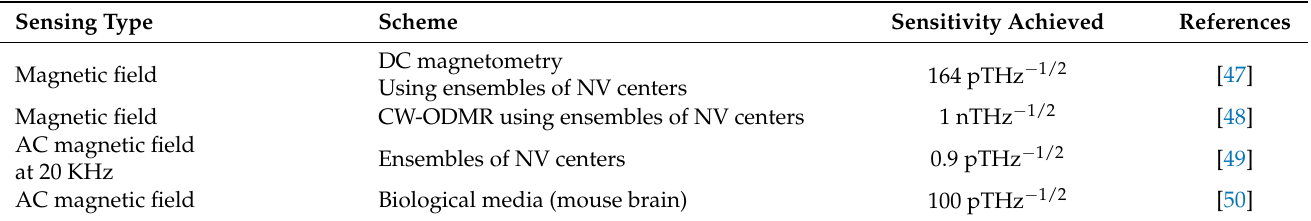
Figure 3. Wide-field magnetic imaging with FNDs. ( a ) Optical spin microscope based on the luminescence of NV centers in FNDs for bioimaging. FNDs are spin coated on a glass coverslip and printed with gold electrodes for microwave signal transmission. The microscope comprises objective, dichroic mirror (DM), filter, and permanent magnet. Fluorescence images are recorded by EMCCD while the sample is excited with a 532 nm laser and a scanning microwave frequency source. ( b ) Schematic of surface-modified FNDs for bio-labeling and tracking. ( c ) The reconstructed magnetic image displaying the presence of labeled magnetic organisms. Table 1. Magnetometry with the highest achieved sensitivity using ensemble and single NVCs.